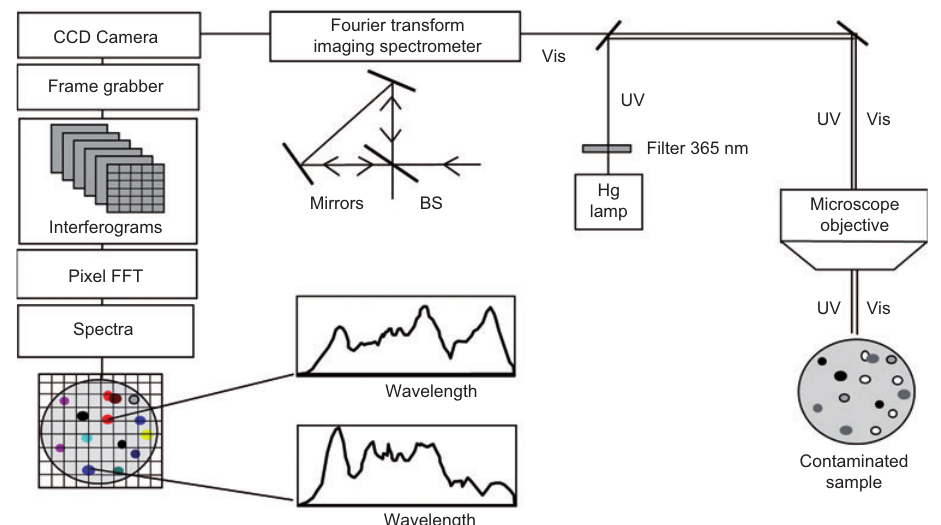
Schematic experimental setup of FT-SIM plant analysis, providing simultaneous chemical analysis in each pixel of the examined surface.